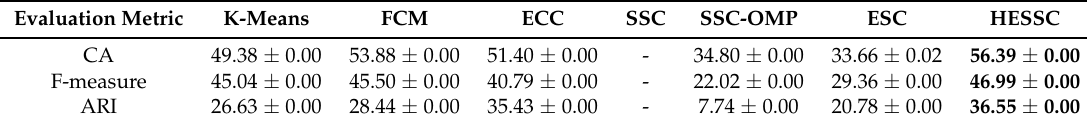
Table 4. Quantitative assessment on the performances of applied clustering algorithms on Trento dataset. The evaluation metrics are reported in mean and standard deviation over 10 trials.